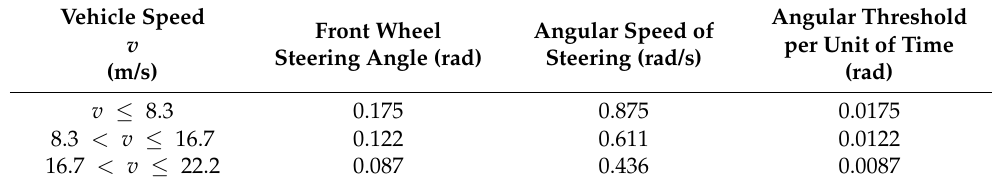
Figure 4. Vehicle avoidance obstacle schematic.